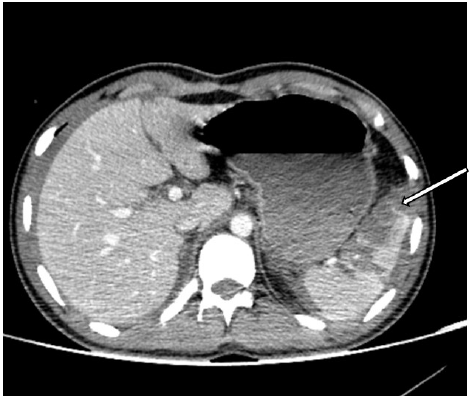
Figure 3. A 50-year-old male patient with road traffic accident. CECT abdomen venous phase image showing a laceration > 3 cm (white arrow) subcapsular hematoma s/o grade III splenic injury.